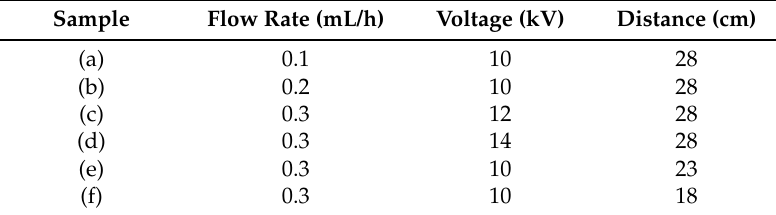
Table 3. Experimental conditions to manufacture PAN nanofiber samples by the electrospinning method.